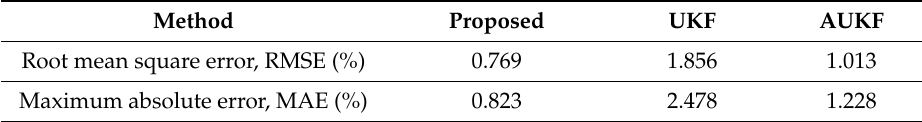
Table 2. Comparison of performances of the di ff erent estimation